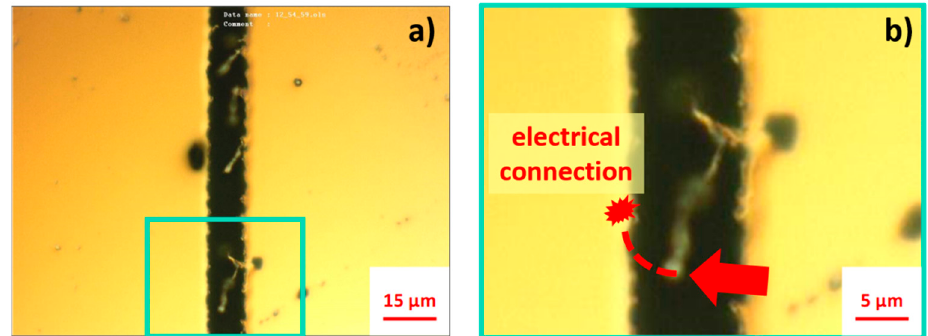
Figure 7. Single P3 laser scribe (12 μ m width), panel ( a ) points out residual gold flakes with dimensions comparable to the scribe width ( b ) magnification of the residual gold flakes region along the P3 scribe (green rectangle in panel ( a )), by emphasizing a possible shunting mechanism occurring upon the application of an external pressure, commonly employed during the panel lamination process.